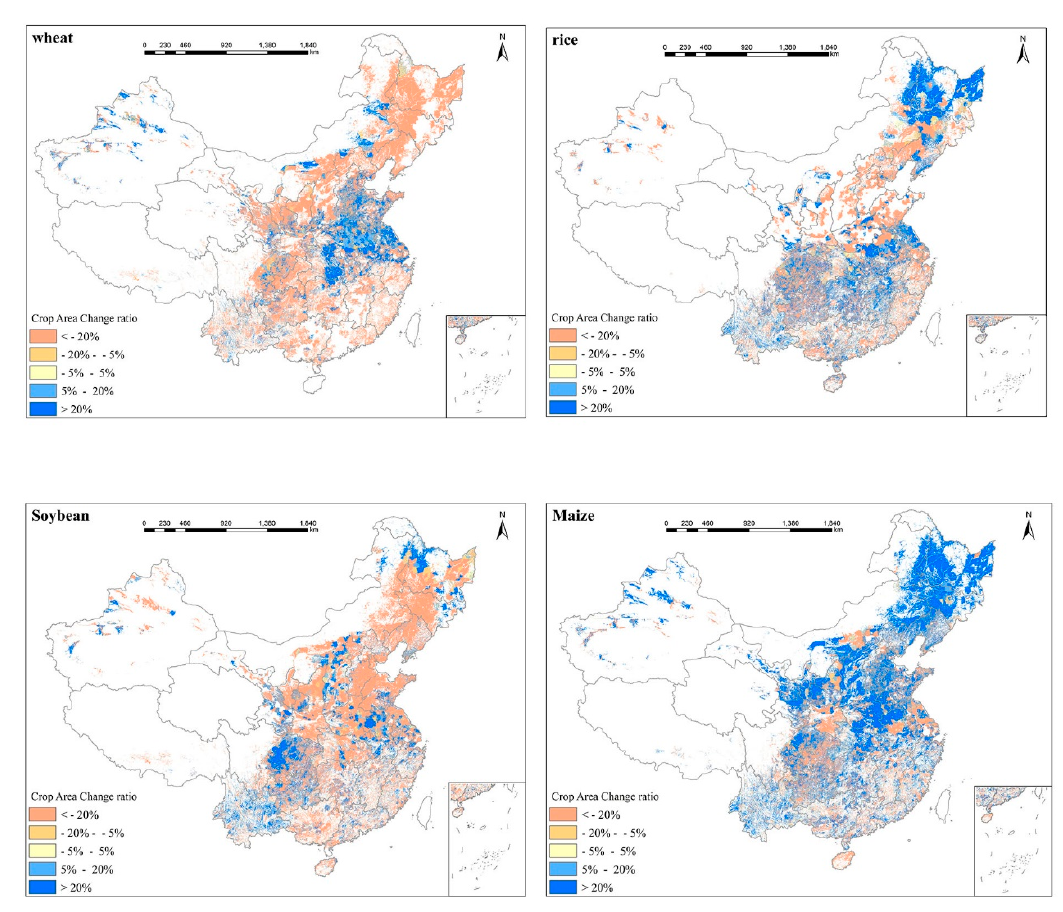
Figure 9. Spatial patterns of area change for wheat, rice, soybean, and maize from 2000 to 2015. For wheat, the cells with decreased area accounted for 74.92% of all cells with area changed. High decrease intensity cells were mainly located in Heilongjiang Province, the Inner Mongolia Autonomous Region, Sichuan Province, and Shaanxi Province, with more than 30% of the cells showing a largely decreased area in these provinces. The high increase intensity cells were mainly located in the Inner Mongolia Autonomous Region, Henan Province, Hubei Province, and Shandong Province, with nearly 40% of the cells showing a largely increased area in these provinces. The Inner Mongolia Autonomous Region had regions with areas of wheat that shifted a lot, as it had plenty of cells with both high decrease intensity and high increase intensity concentratedly distributed. For rice, the cells with decreased area accounted for 57.32% of all cells with area changed. High decrease intensity cells were mainly located in Sichuan Province, Guizhou Province, the Inner Mongolia Autonomous Region, and Guangxi Province, with more 20% of the cells showing a largely decreased area in these provinces. The high increase intensity cells were mainly located in Heilongjiang Province, Hunan Province, Yunnan Province, and Sichuan Province, with nearly 40% of the cells showing a largely